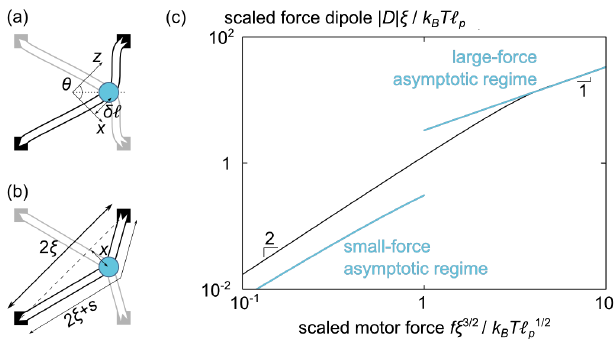
FIG. 4. Contraction induced by filament deformation. (a) For small motor forces, the cost of filament deformation is mainly due to bending. The ð x; z Þ coordinate system is given for the darker filament. (b) For large motor forces, filaments are fully stretched. (c) Crossover of the force dipole D between the asymptotic regimes of Eqs. (15) and (16). The interpolating black line is discussed in the Supplemental Material